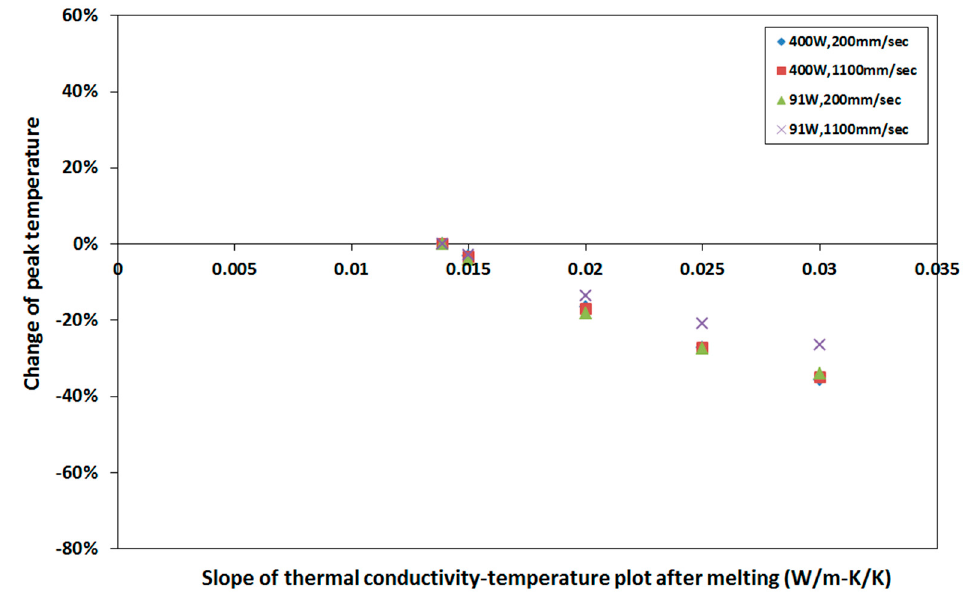
Figure 17. Sensitivity of peak temperature to thermal conductivity. Change of peak temperature with respect to that calculated with base thermal conductivity at varying process parameters. Slope of thermal conductivity–temperature plot after the melting point is varied only .